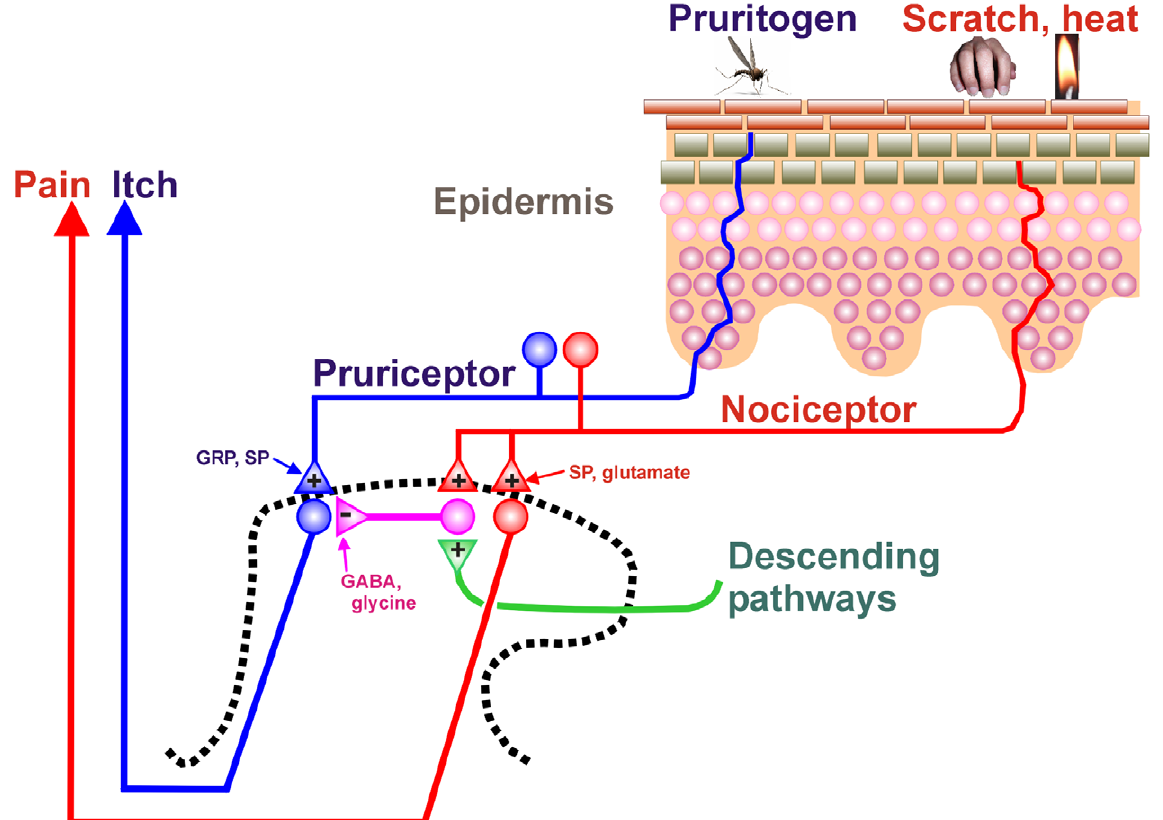
Figure 7. Schematic diagram showing epidermis (upper right) and an outline of the spinal dorsal horn (dashed line, lower left). + : excitatory synapse; -: inhibitory synapse. See text for further discussion.